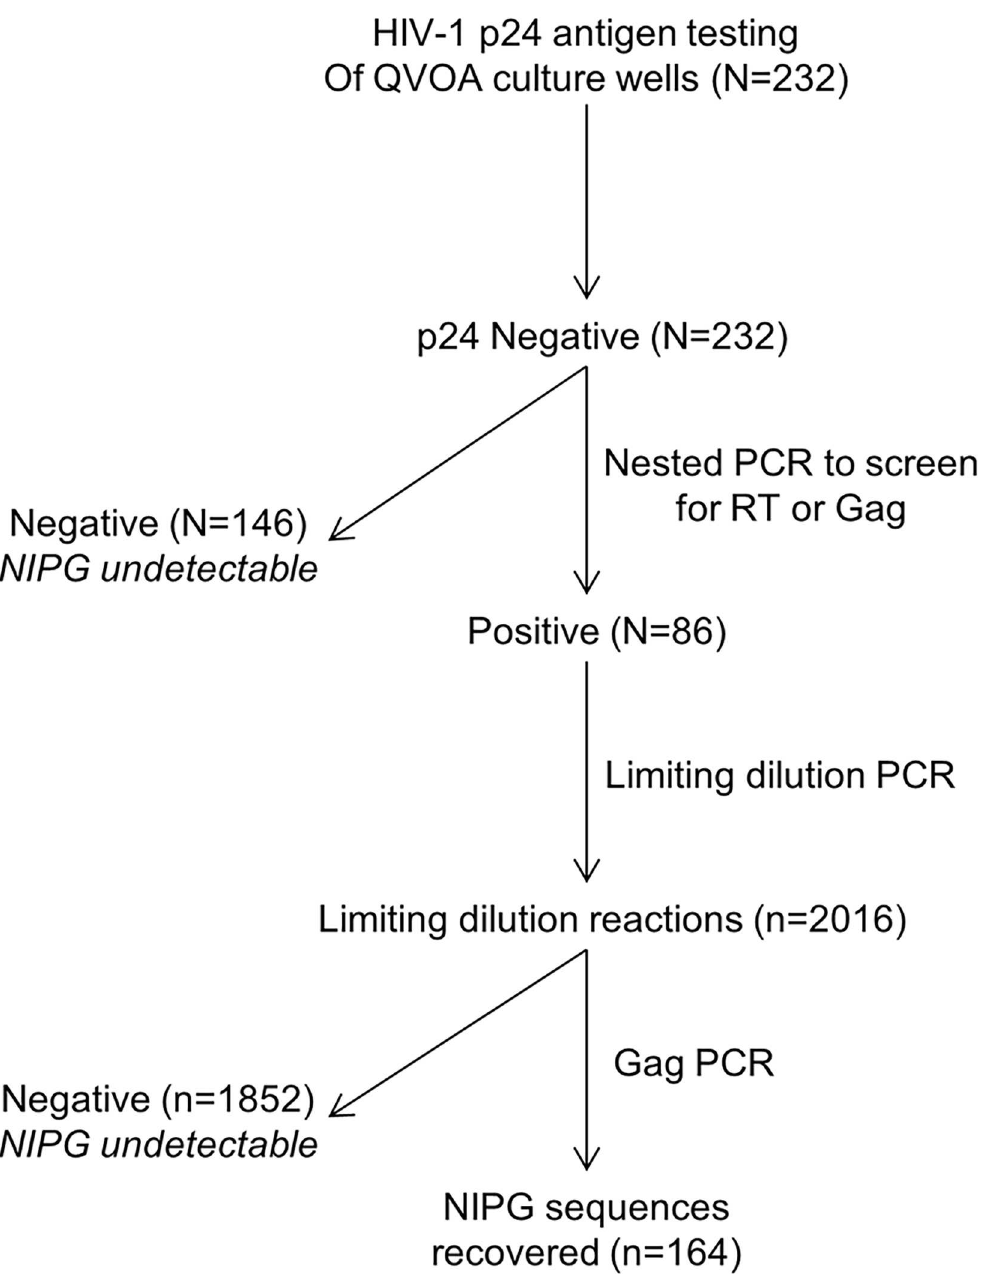
Fig 1. Flow diagram of QVOA wells yielding NIPG. “N” representsthe number of QVOA culture wells; “n” represents the number of PCR reactions performed at limiting dilutionand therefore, the number of NIPG recoveredat a clonal level. QVOA : quantitative viral outgrowthassay , NIPG : non-inducedproviralgenomes , PCR : polymerase chain reaction